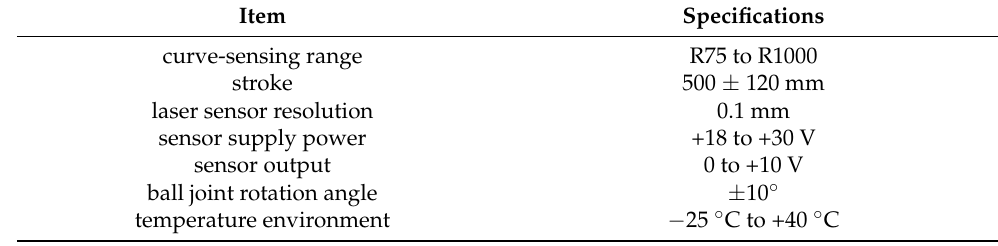
Table 2. Specifications of the curvature sensor.